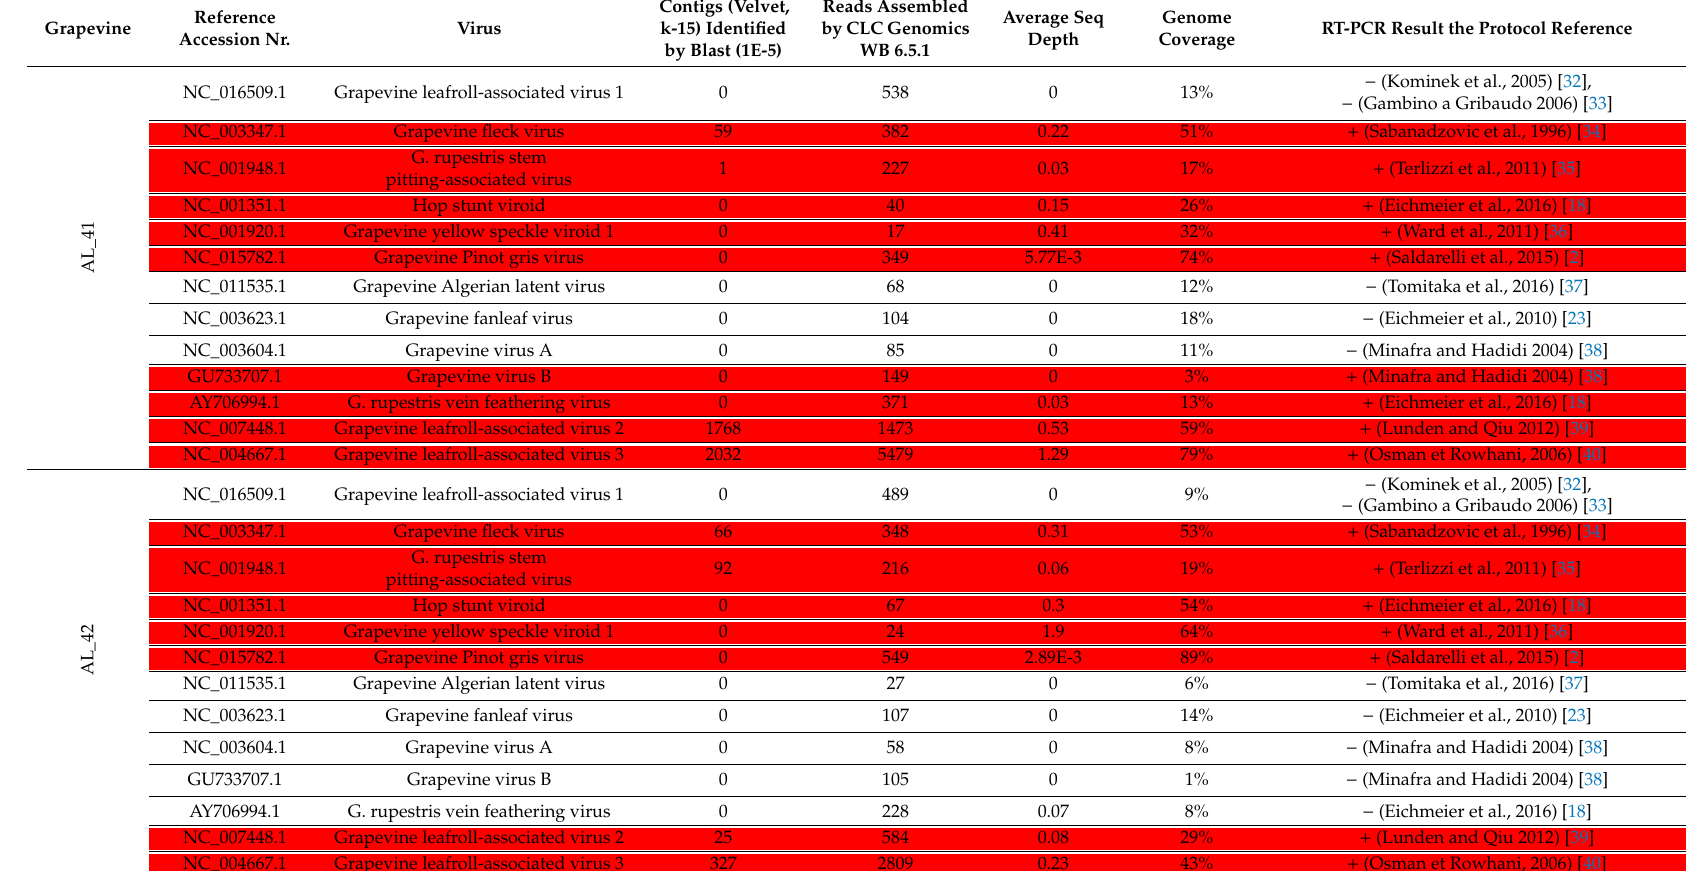
Table 3. Results of small RNA sequencing and RT-PCR